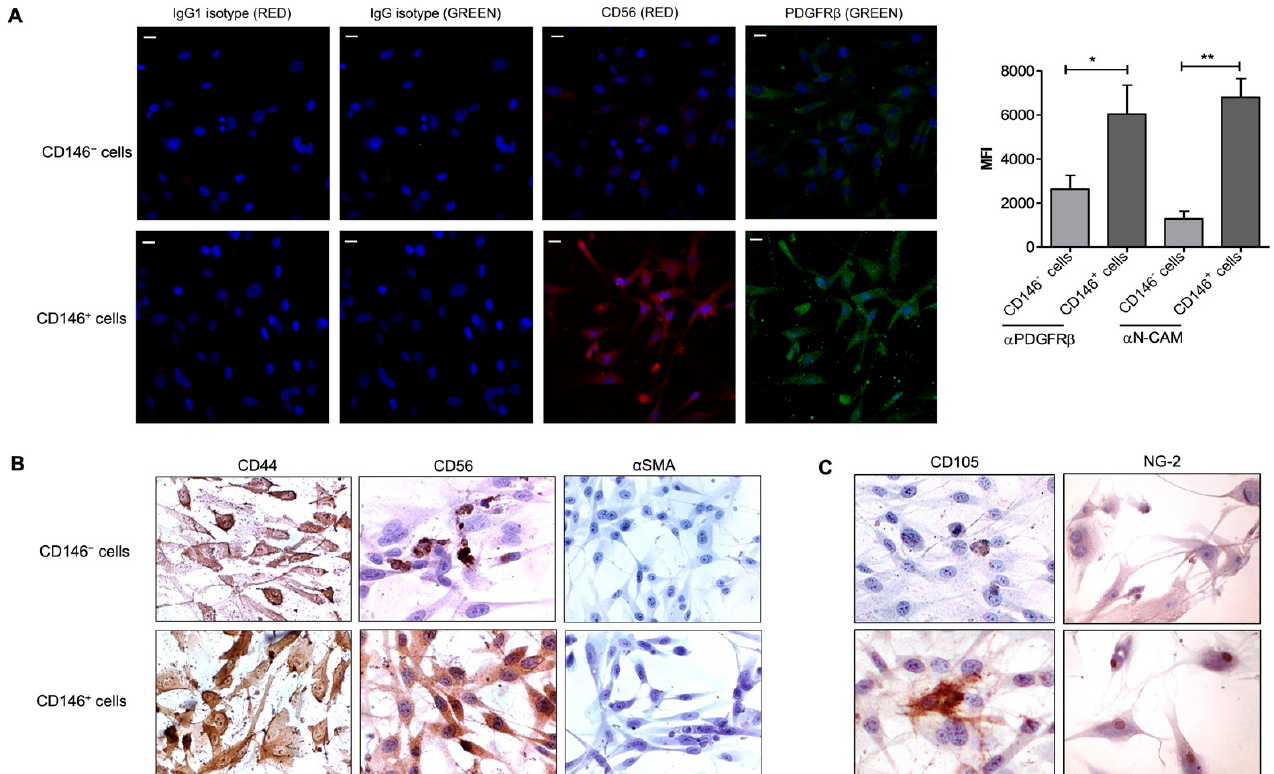
Figure 5. Expression of CD56 (NCAM). ( A ) Representative confocal images of CD146 − cells (upper side) and CD146 + (lower side). Immunofluorescence was performed to identify PDGFR β and CD56 expression by both the cell subpopulations. Images display PDGFR β in green, CD56 in red, and cell nuclei in blue; magnification, 40 × . Scale bar = 25 µ M. The corresponding IgG- (green) or IgG1-isotype (red) was used as a negative control. The bar graph was generated using the mean fluorescence intensity of two different experiments performed in triplicates. One-way ANOVA and Bonferroni’s post-test were used to compare the data; * p ≤ 0.05, ** p < 0.01. ( B ) CD146 − (upper) and CD146 + (lower) cells were stained for peculiar mesenchymal markers CD44, CD56 (NCAM), and α SMA. Images were taken at 60 × magnification. ( C ) Immunostaining images represent CD146 − (upper) and CD146 + cells (lower) for the expression of common mesenchymal markers, CD105 and NG-2 at 40 × and 20 × magnification, respectively. Images are representative of one out of three experiments performed in duplicates. NCAM—neural cell adhesion molecule